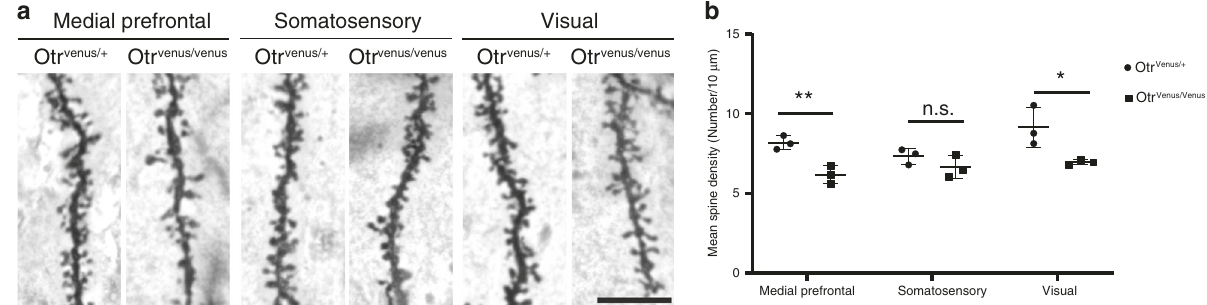
Fig. 8 Reduced spine density in Otr KO mice. a Example of Golgi-stained spines in Otr heterozygote ( Otr Venus/ + ) and Otr KO ( Otr Venus/Venus ) in the medial prefrontal, the somatosensory, and the visual cortex. Scale bar (same across images) = 10 µ m. b Otr KO mice showed signi fi cantly reduced spine density in the medial prefrontal and visual cortices compared to Otr heterozygote mice. * p < 0.05, ** p < 0.01, n.s. not signi fi cant. Error bars = mean ± standard